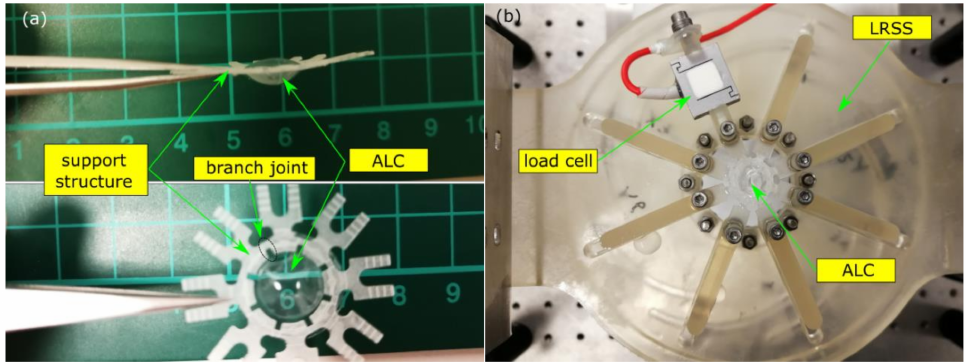
Figure 4. Accommodating test: ( a ) an artificial lens capsule (ALC) with support structure; ( b ) ALC on the lens radial stretching system